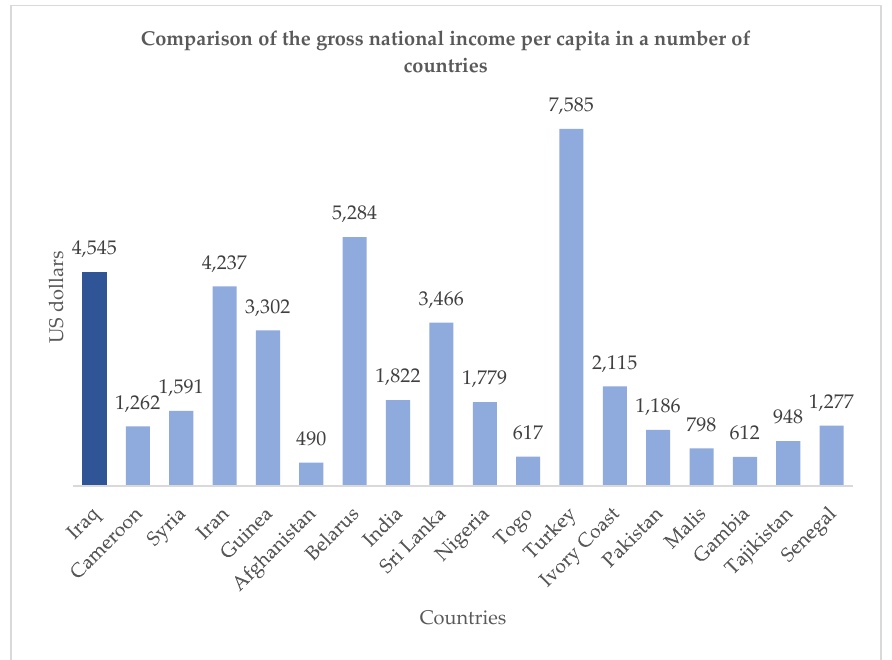
Figure 8. Comparison of the gross national income per capita in a number of countries, in US dollars [5].